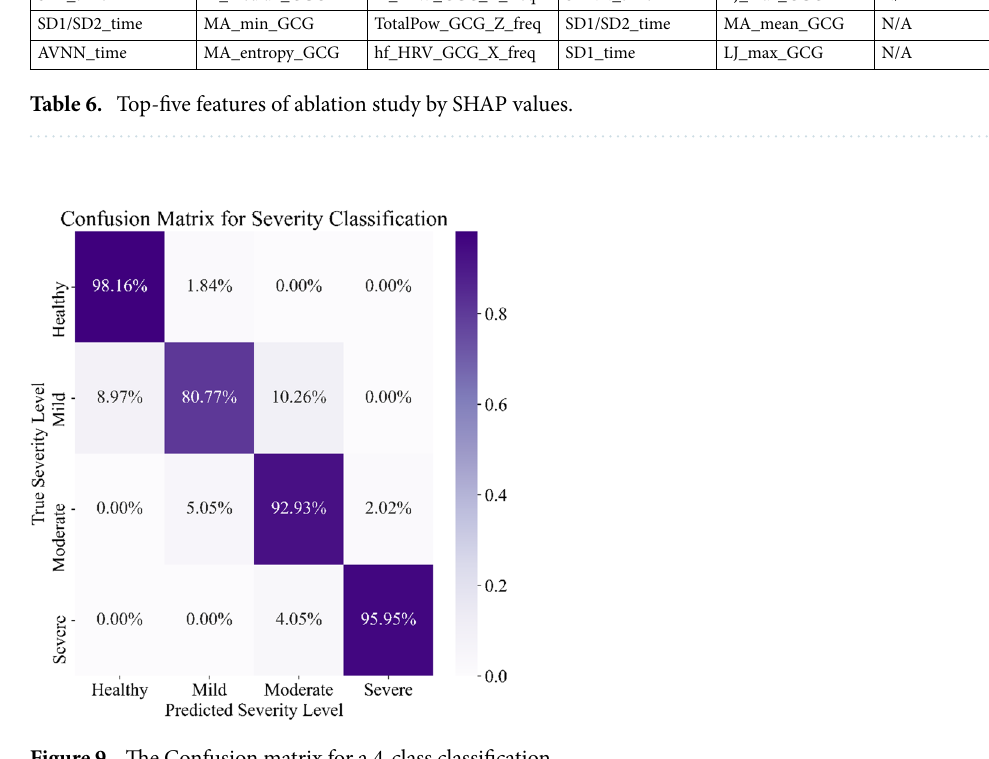
Figure 9. The Confusion matrix for a 4-class